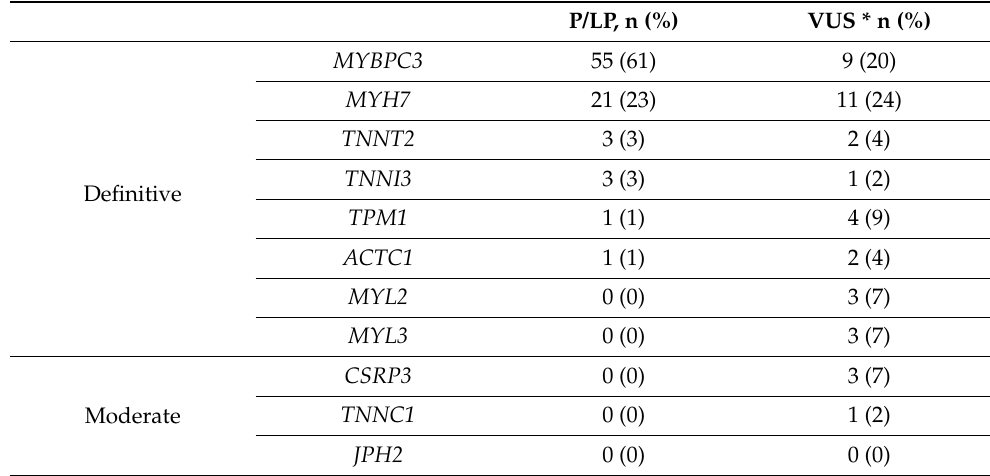
Table 2. Patient-level variant analysis, with the number (n) and percentage (%) of the identified variants in the different genes. Definitive: genes with definitive evidence for HCM